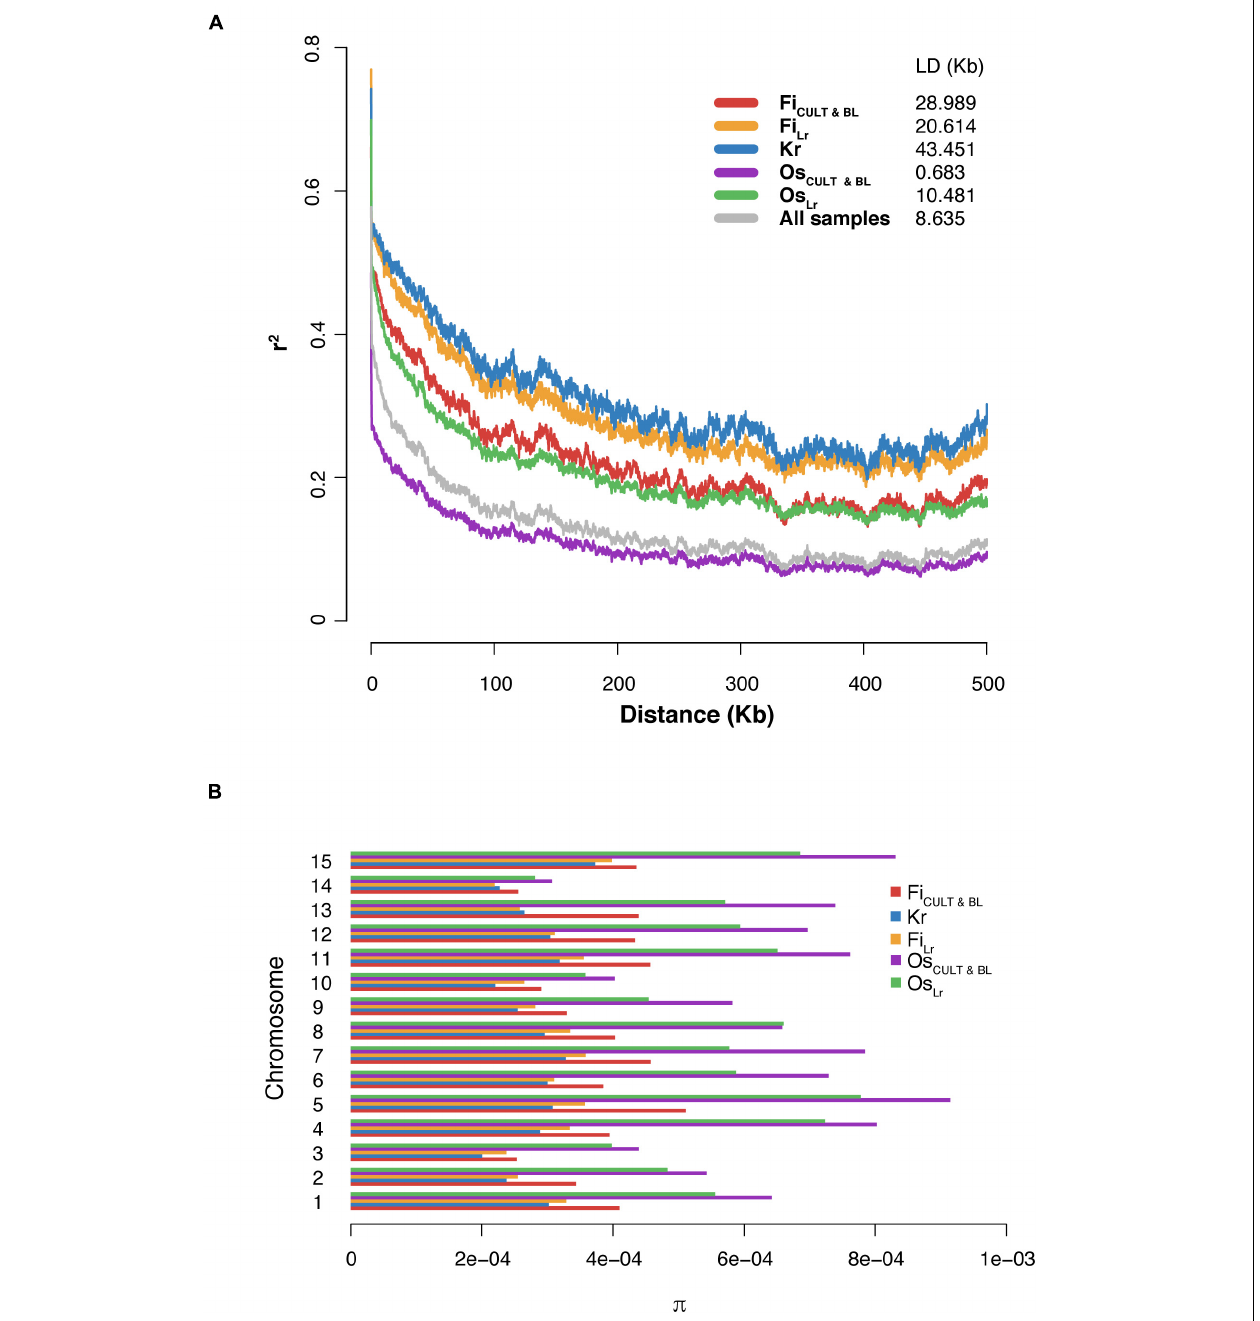
FIGURE 4 | The LD decay and genetic diversity in groups of accessions with different selection status. (A) Graphs of the LD decay. (B) Variation of the median nucleotide diversity value between groups presented by